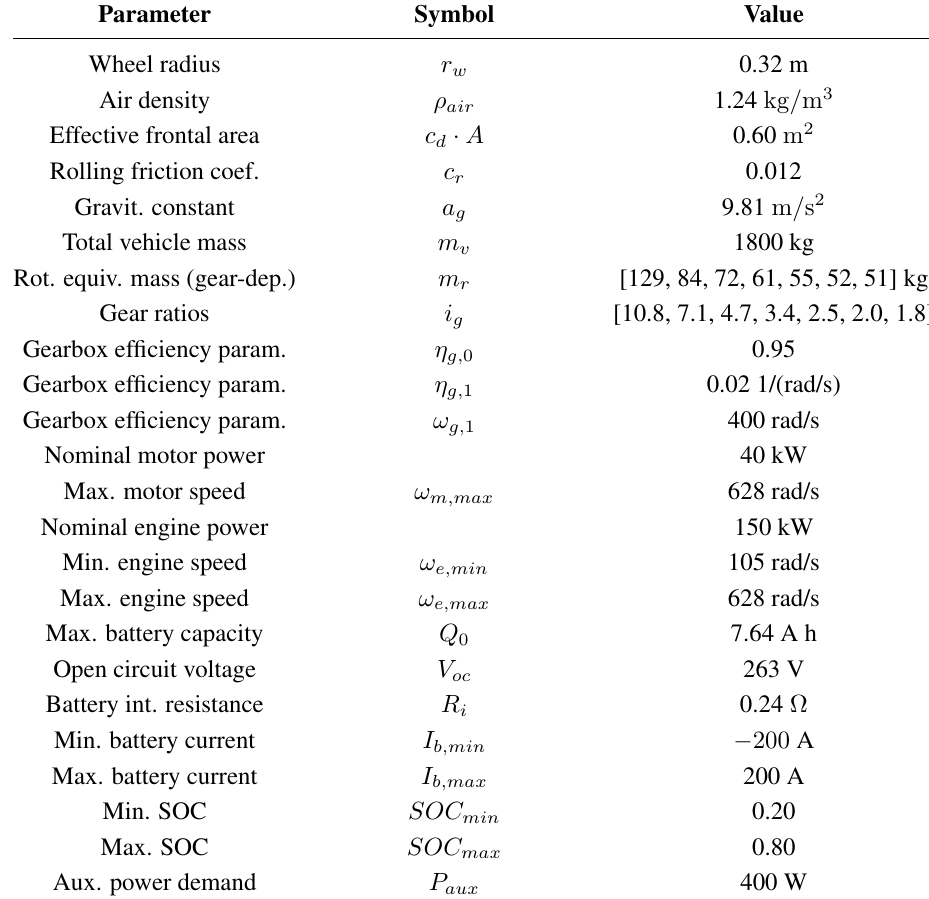
Table 1. Parameters of the pre-transmission parallel HEV executive class passenger car. SOC: state of